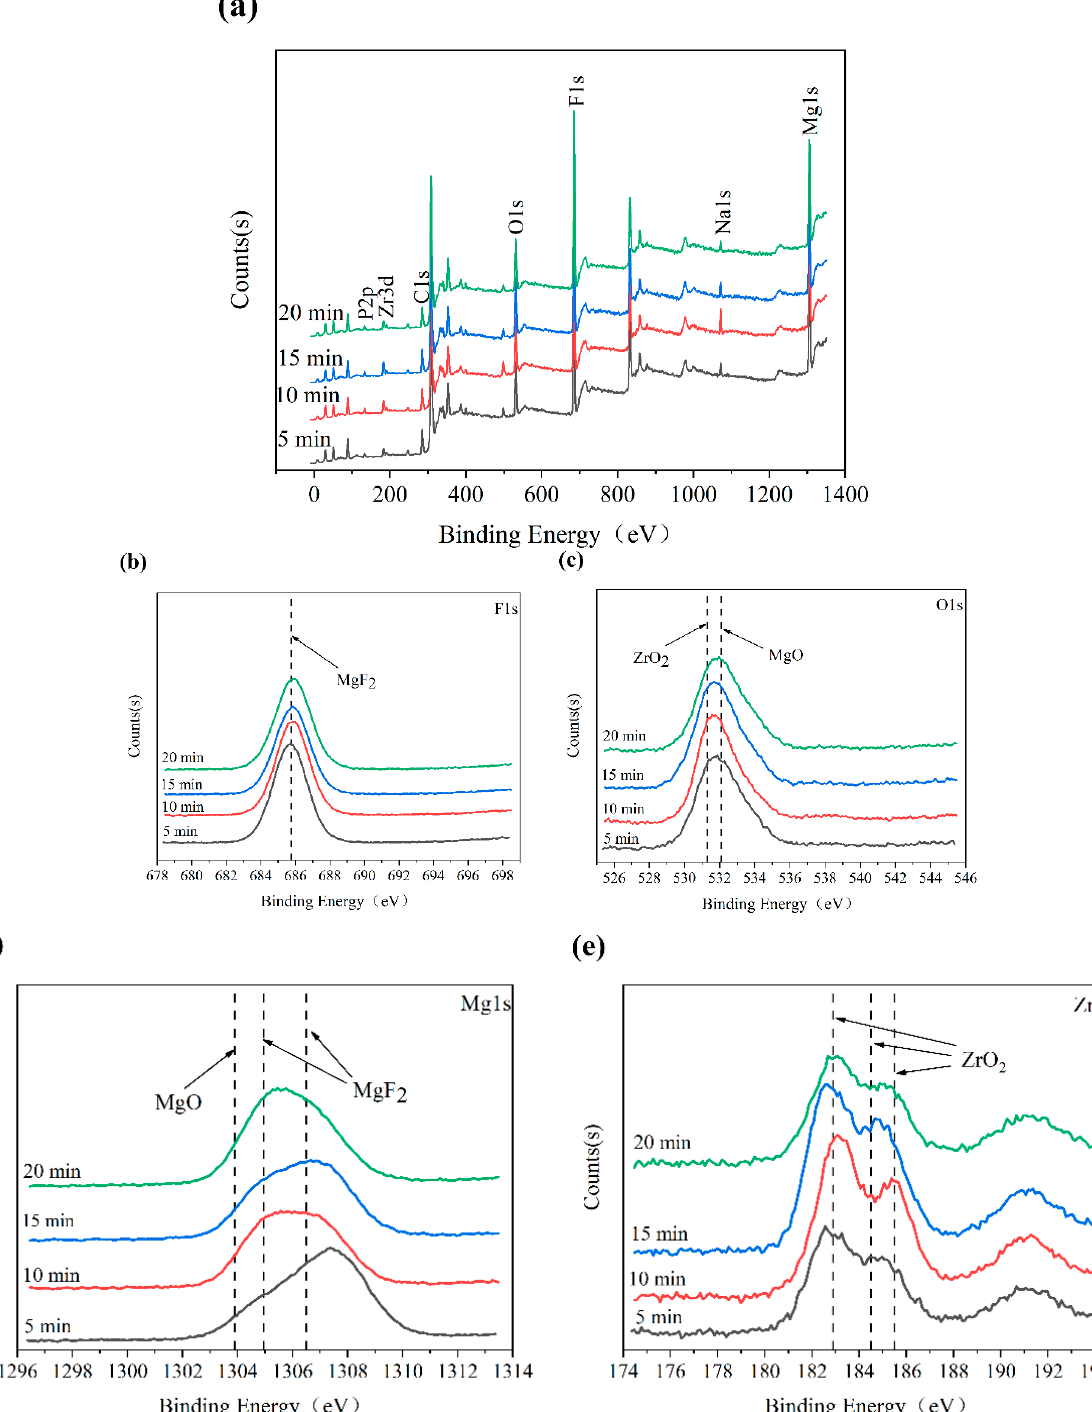
Figure 7. XPS spectra of MAO coatings: ( a ) full spectrum; ( b ) F 1s; ( c ) O 1s; ( d ) Mg 1s; ( e ) Zr 3d.